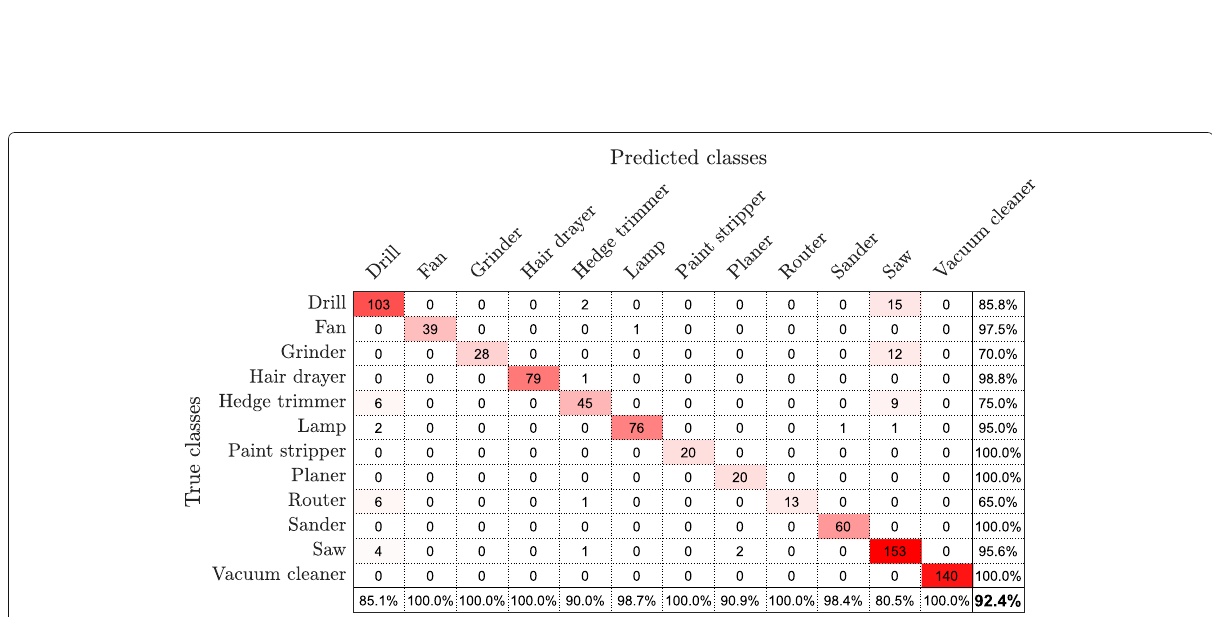
Fig. 15 Classification result as a confusion matrix using model parameters ˆ p i and ˆ a i . The bottom rightmost cell gives the classification rate, the rightmost column contains the recall values, and the bottom row the precision